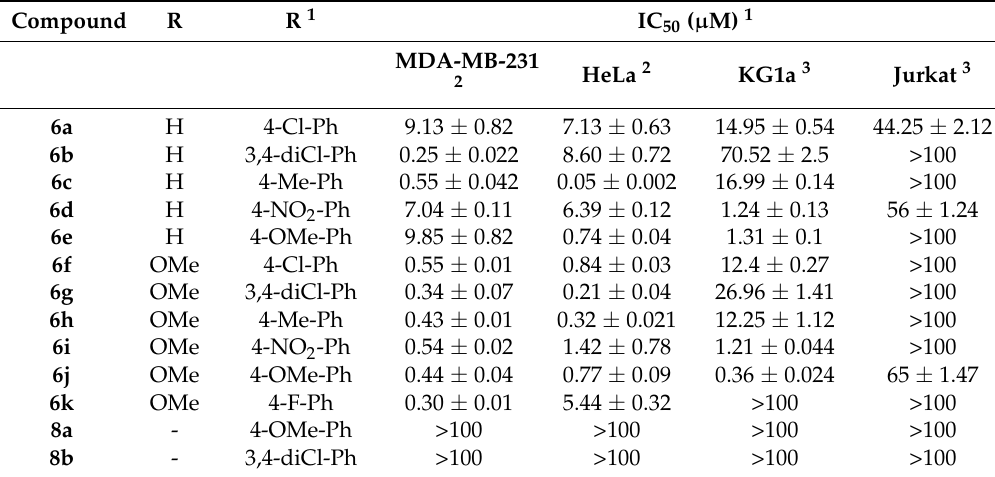
Table 1. Growth inhibitory activity (IC 50 , µ M) values for quinolin-4-yl- N -aryloxadiazol-2-amines ( 6a–k ) and quinolin-4-yl-benzoylmethylthiotriazoles ( 8a–b ) in human cancer cell lines MDA-MB-231